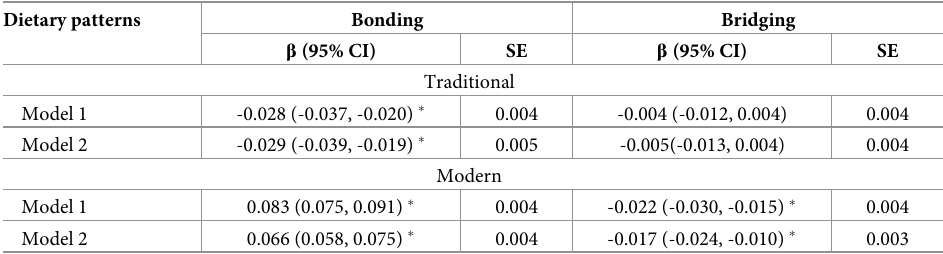
Model 1: Crude model; Model 2: Adjustment for sex, age, education, income and ethnicity; CI: Confidence